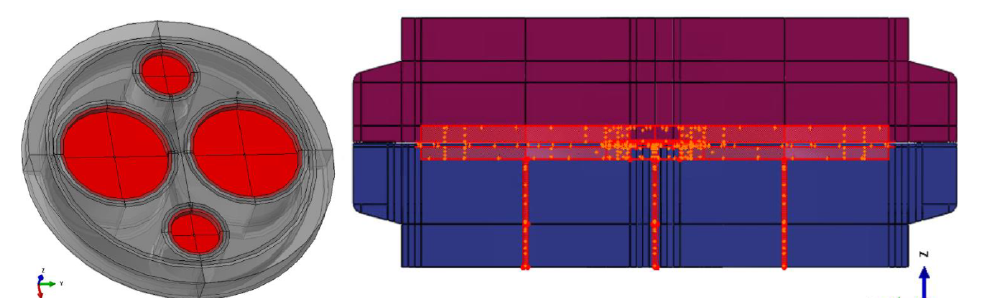
Figure 12. Pressure application in fixed flange.